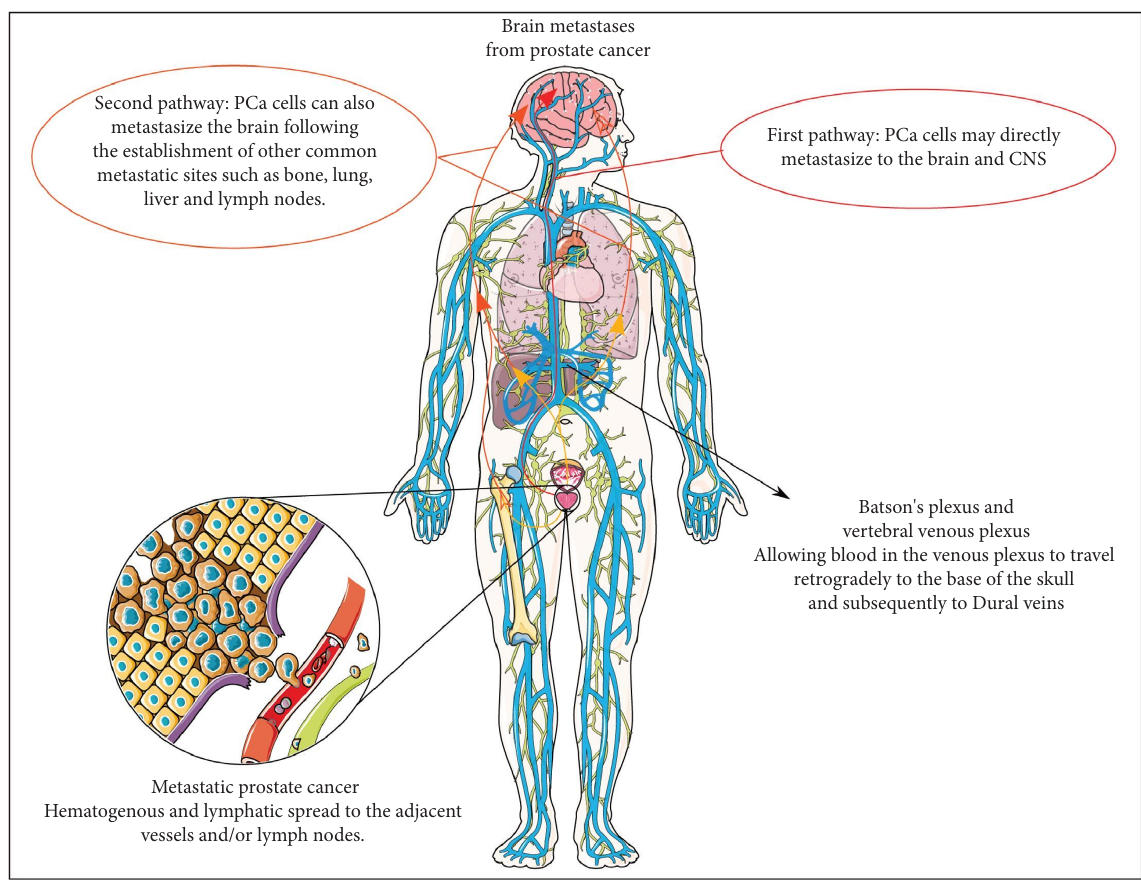
Figure 2: Te pathways and mechanisms of brain metastases in prostate cancer (this fgure was drawn using images from Servier medical art (https://smart.servier.com) licensed by a Creative Commons Attribution 3.0 unported